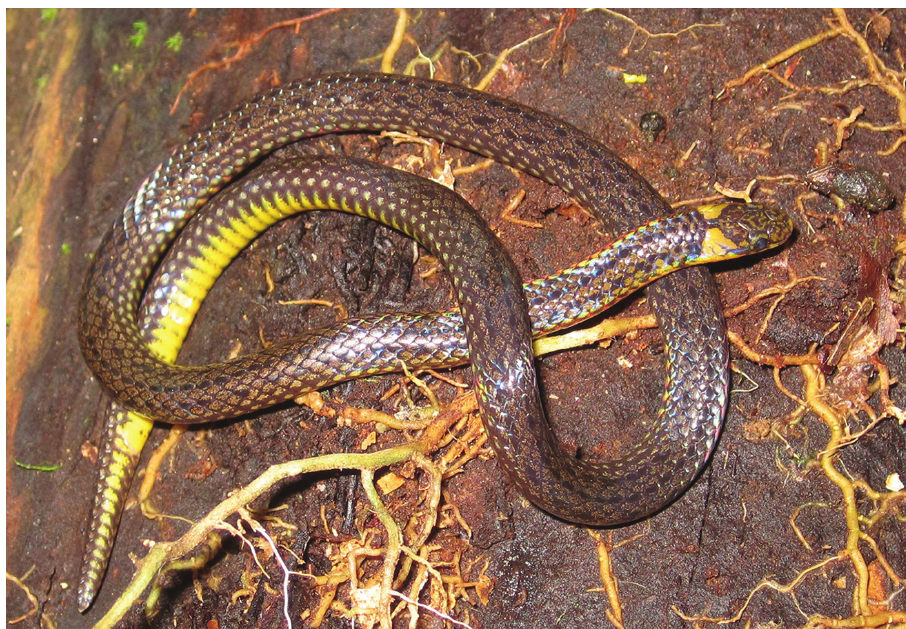
Figure 64. Calamaria gervaisi from Mt. Hilong-hilong, Municipality of Remedios, T. Romualdez, Agusan del Norte Province. Photo: